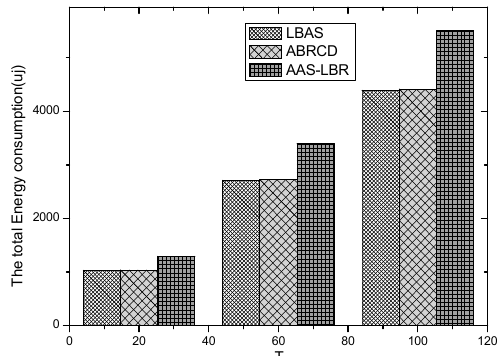
Figure 34. Total energy consumption of three schemes under different cycles with r = 28 m.